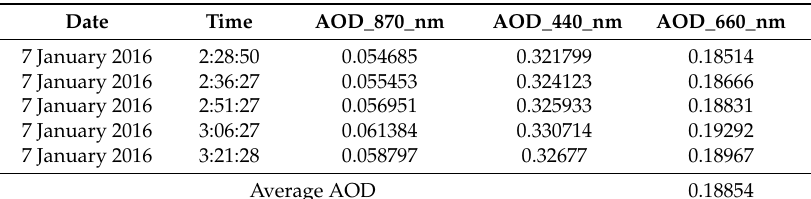
Table 3. The aerosol robotic network aerosol optical depth (AOD) data.